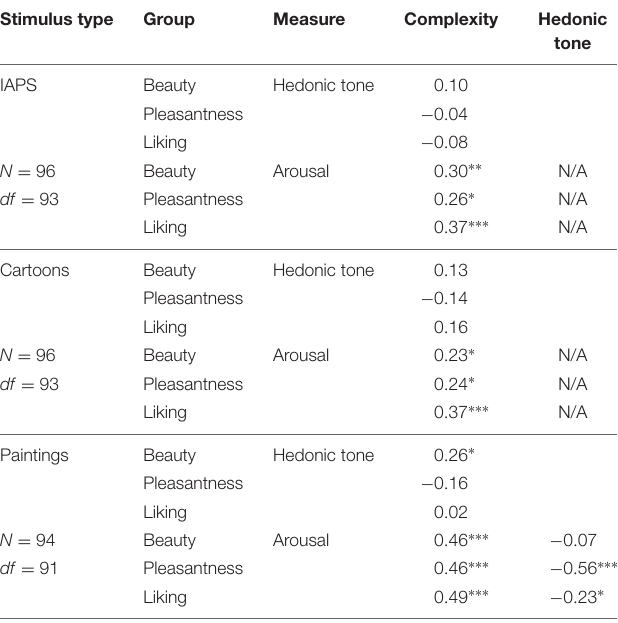
TABLE 4 | Partial Spearman’s rank order correlations controlling for familiarity between measures of complexity, arousal and hedonic tone in response to IAPS pictures, cartoons and